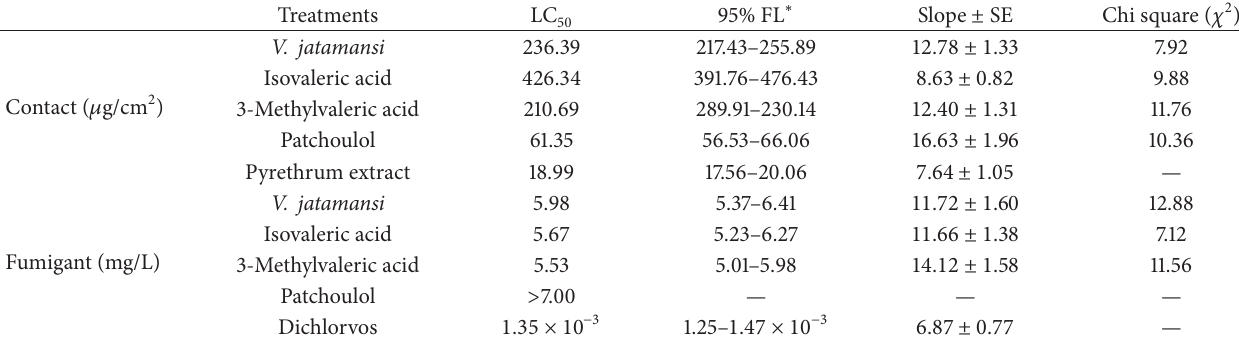
Table 2: Contact and fumigant toxicity of the essential oil of Valeriana jatamansi and its isolated compounds against Liposcelis bostrychophila. Treatments